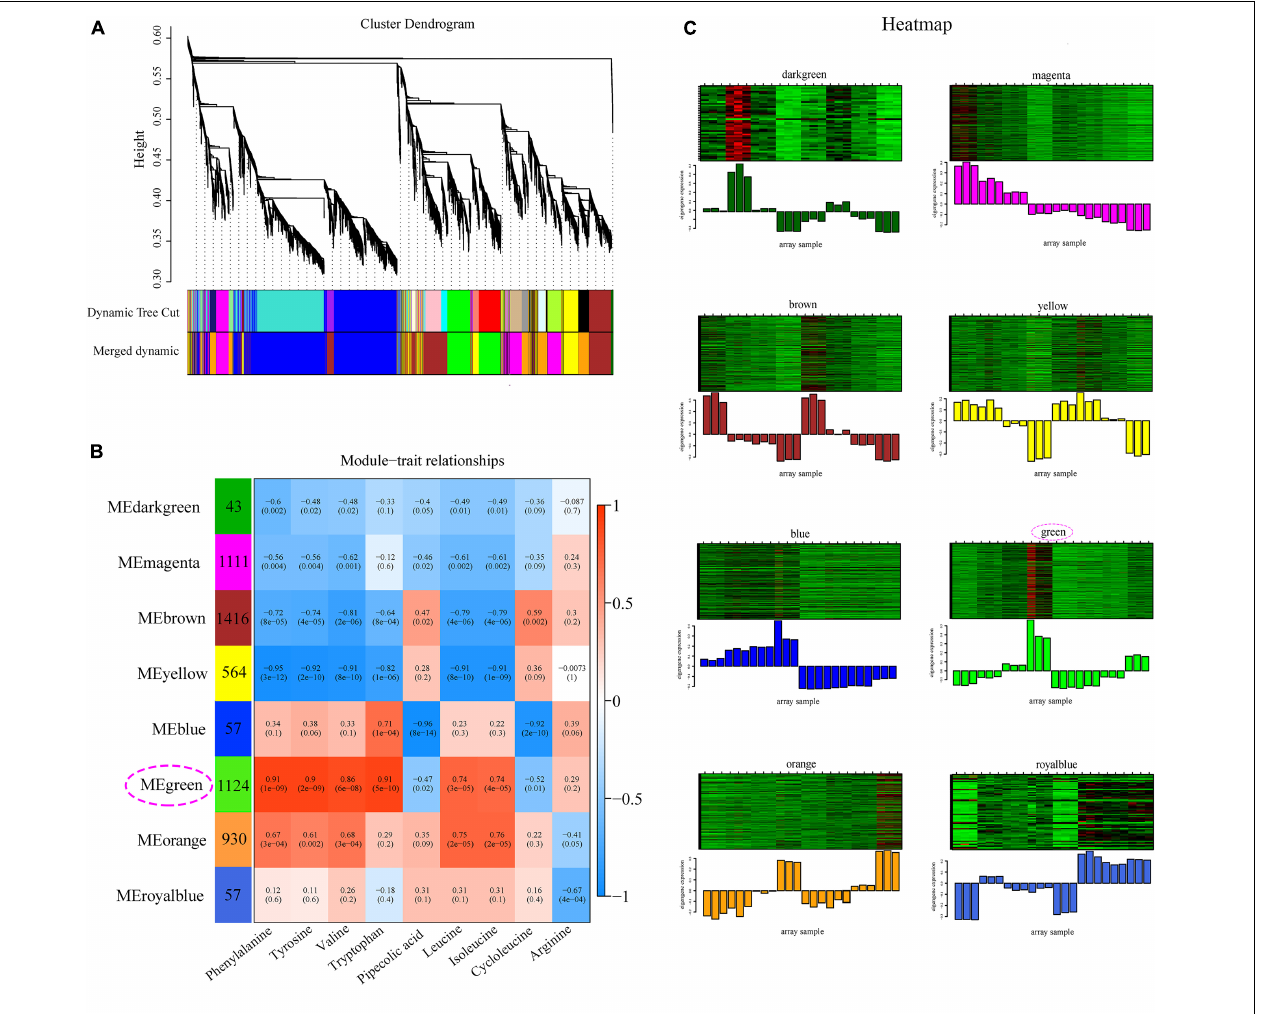
FIGURE 4 | Weighted gene co-expression network analysis (WGCNA) of differentially expressed genes (DEGs) under drought stress. (A) Cluster dendrogram of all the DEGs. (B) Module–trait relationship heatmap of eight modules and nine indicator amino acids. (C) Gene expression heatmap of each module. The below column diagram represents the total variation trend of the genes in specific